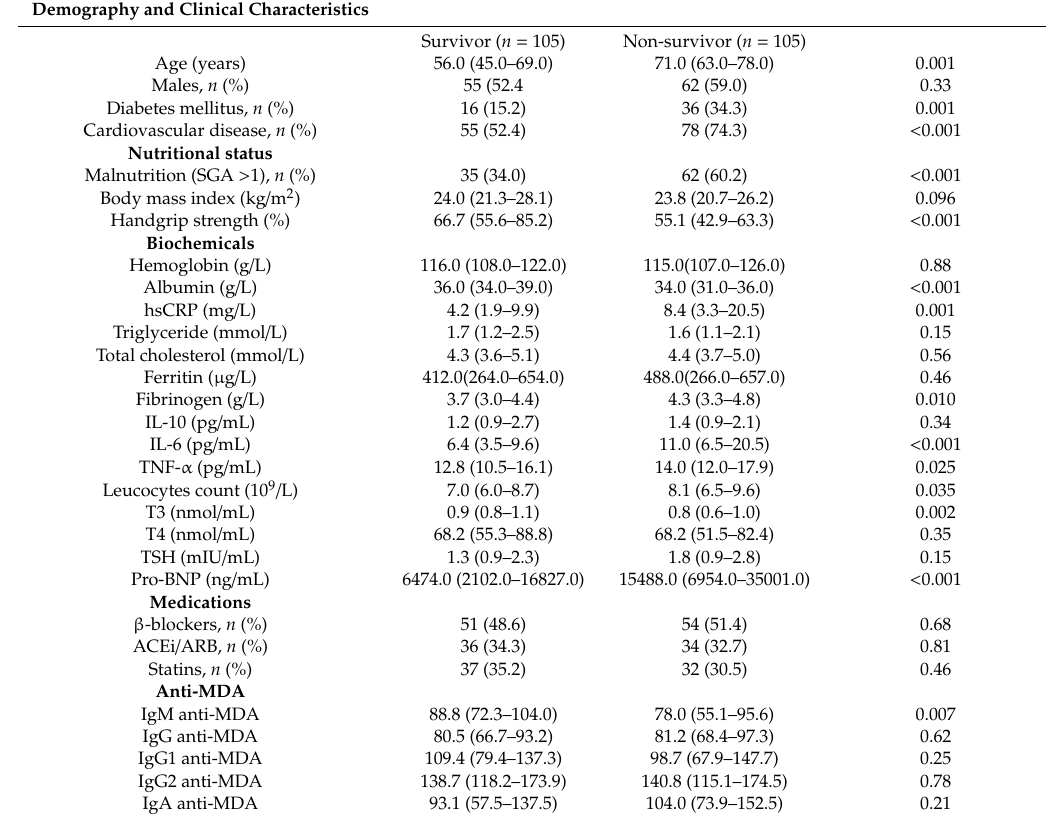
Table 1. Baseline characteristics and anti-MDA in 210 HD